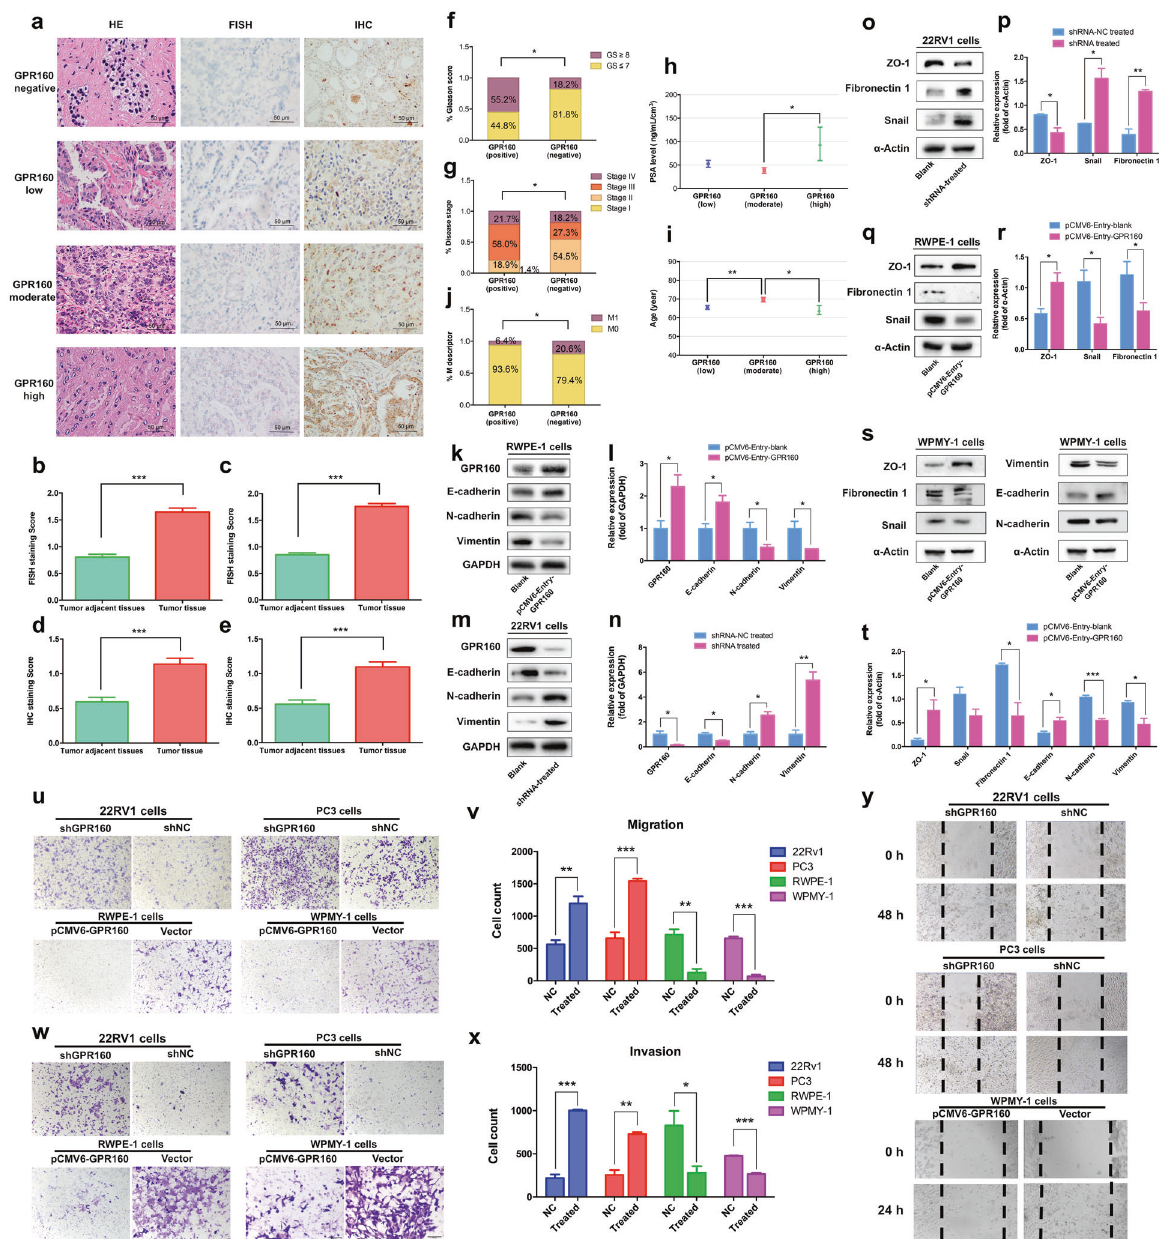
Fig. 1 Higher expression of GPR160 in cancerous human prostate tissues and relationship between GPR160 expression levels and clinical characteristics of enrolled patients. a Images of GPR160 expression detected by RNAscope ® (mRNA, FISH)) and immunohistochemistry (protein, IHC). HE, hematoxylin and eosin, scale bars, 50 μ m. b 143 samples containing both normal and cancerous tissues used for mRNA analysis with paired t test. c 167 samples containing cancerous and 143 samples containing normal tissues used for mRNA analysis with unpaired t test. d 112 samples containing both normal and cancerous tissues used for immunohistochemistry analysis with paired t test. e 140 samples containing cancerous and 112 samples containing normal tissues used analysis with unpaired t test. Data presented are means ± SEM of up to three independent reading; *** P < 0.0001. f Gleason scores vs. GPR160 mRNA levels in the prostate cancer tissue. g Disease stage vs. GPR160 mRNA levels in the prostate cancer tissue. h PSA levels in patients with elevated GPR160 mRNA transcription. i Age-related GPR160 protein intensity. j M scores in patients with or without GPR160 protein expression. Data shown are means ± SEM; * P < 0.05 using unpaired t test. k Expression of the epithelial – mesenchymal transition (EMT) hallmarks E-cadherin, N-cadherin, and vimentin as well as GPR160 in blank and GPR160 gene transfected cells. l Quantitative densitometric analysis of k . m Expression of the three EMT hallmarks and GPR160 in blank and GPR160 gene silenced cells. n Quantitative densitometric analysis of m . o Expression of the EMT hallmarks ZO-1, snail, and fi bronectin 1 in blank and GPR160 gene silenced cells. p Quantitative densitometric analysis of o . q Expression of the EMT hallmarks ZO-1, snail, and fi bronectin 1 in blank and GPR160 gene transfected RWPE-1 cells. r Quantitative densitometric analysis of q . s Expression of the EMT hallmarks ZO-1, snail, and fi bronectin 1 in blank and GPR160 gene transfected WPMY-1 cells. t Quantitative densitometric analysis of s . u , Migration of GPR160 gene silenced or transfected cells. v Quantitative densitometric analysis of u . w Invasion of GPR160 gene silenced or transfected cells. x Quantitative densitometric analysis of w . y Wound-healing assay in GPR160 gene silenced or transfected cells. Data presented are means ± SEM obtained from three independent experiments; * P < 0.05, ** P < 0.01, and *** P < 0.001 using Student ’ s t test